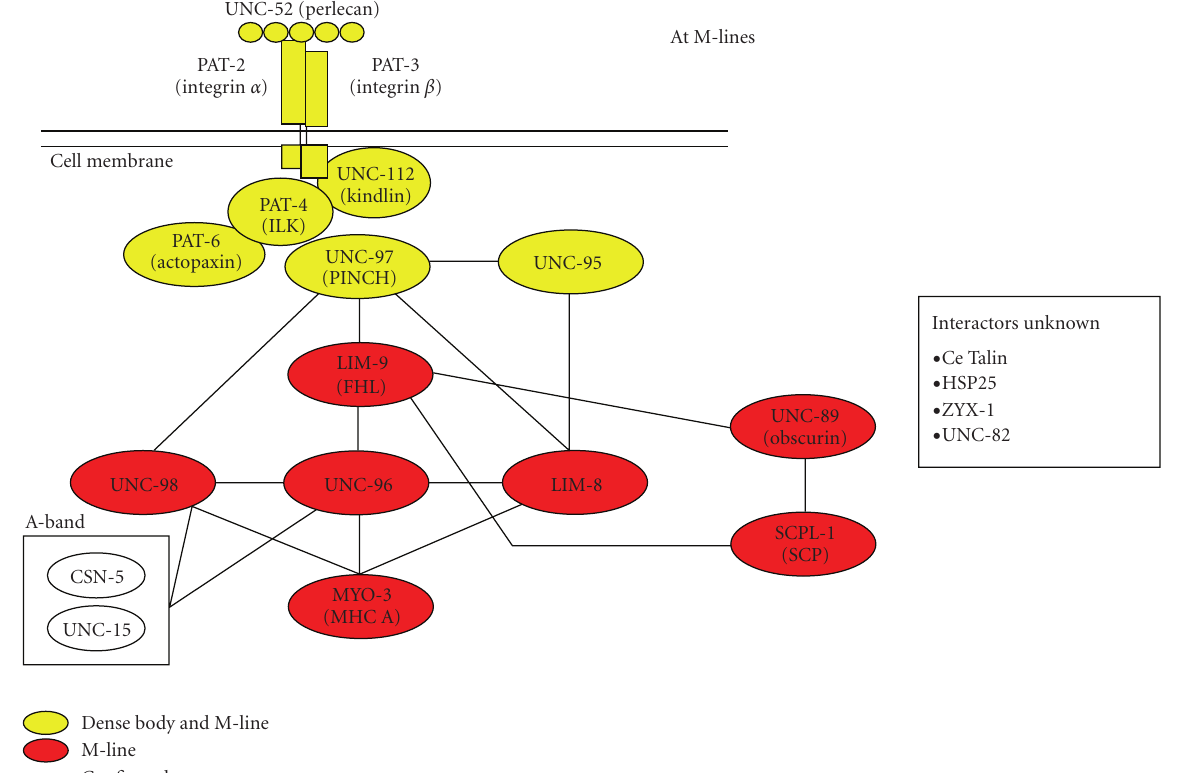
Figure 2: A protein interaction matrix for M-lines in C. elegans striated muscle. The myofilament lattice is located close to the surface and anchored by M-lines and dense bodies to the muscle cell membrane. At these attachment structures, UNC-52 (perlecan) is located in the ECM, and by homology is likely to interact with an integrin αβ heterodimer (PAT-2 and PAT-3). Inside the muscle cell, the cytoplasmic tail of PAT-3 ( β integrin) is associated with a complex of four conserved proteins [UNC-112 (Kindlin), PAT-4 (ILK), PAT-6 (actopaxin), UNC-97 (PINCH)]. UNC-95 is also found at both M-lines and dense bodies. At M-lines, specific proteins link UNC-97 (PINCH) to myosin heavy chains (MHC A). These are UNC-98, LIM-9 (FHL) and UNC-96, LIM-8, and UNC-95 and LIM-8. UNC-98, UNC-96 and LIM-8 have all been shown to interact with portions of the rod domain of MHC A. LIM-9 links to the giant protein UNC-89 (obscurin) and to the phosphatase SCPL-1 (SCP). Additionally, UNC-98 and UNC-96 interact with UNC-15 (paramyosin) and to CSN-5 (COP9 signalosome component), but these interactions occur outside the M-line. The box on the right indicates that there are four more proteins that have been reported to reside at the M-line (Ce Talin, HSP25, ZYX-1 (zyxin), and UNC-82 (ARK5/SNARK)), but these have not yet been connected with components of the interaction matrix. Lines indicate interactions that were identified by 2-hybrid screens and later shown to occur with purified proteins in vitro. All proteins indicated have been localized to M-lines by specific antibodies and/or GFP fusions. References for all the interactions have been cited in the text except for the LIM-8/UNC-95 interaction (A. Simionescu, H. Qadota, and G. Benian, unpub.